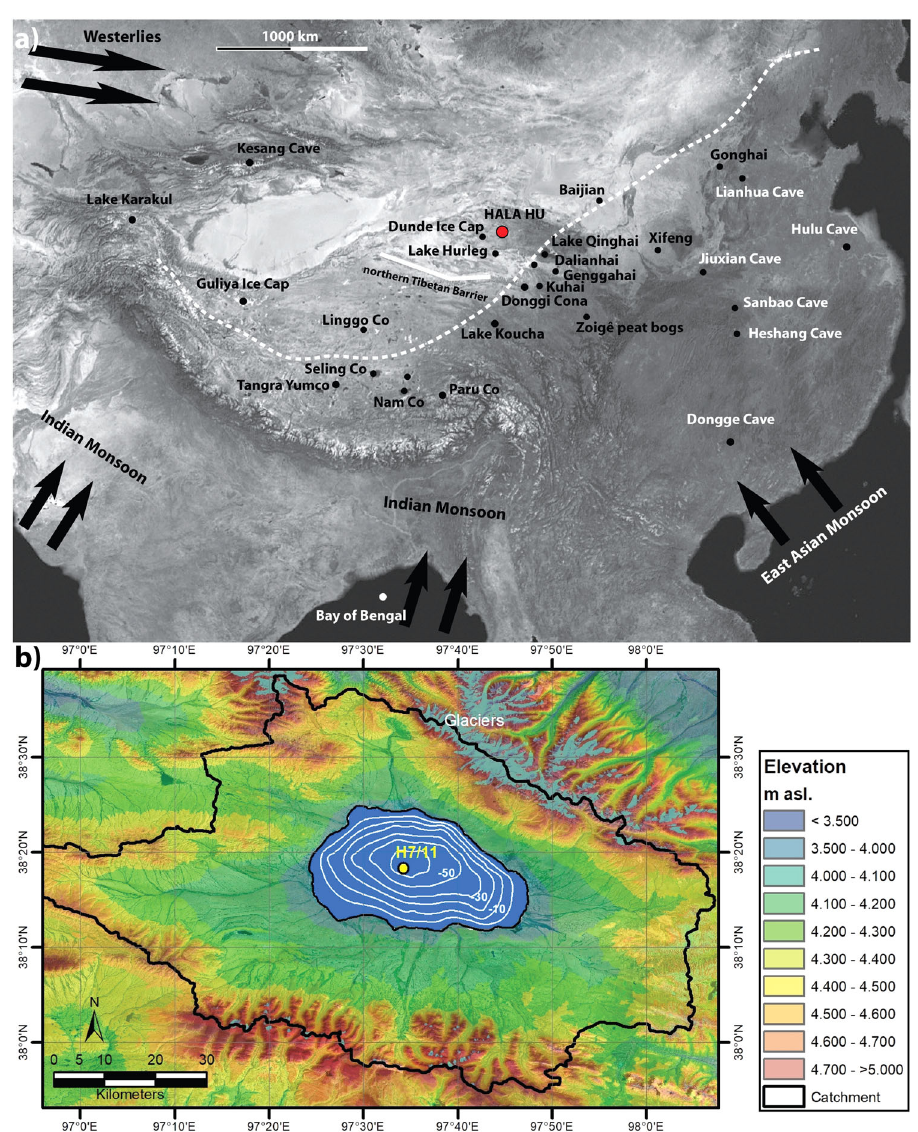
Fig. 1 Study site. a Location of Hala Hu and regional paleorecords as mentioned in the text. Dashed white line indicates approximate boundary zone of present day ASM in fl uence. Northern Tibetan Barrier is the proposed maximum extent of mid-Holocene monsoon in fl uence 102 . b Hala Hu and catchment with coring location of H7 and H11